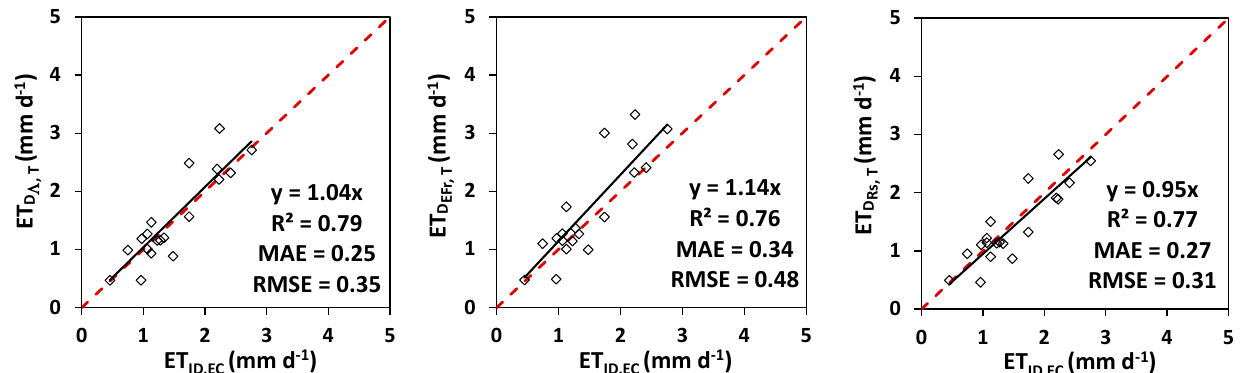
Figure 7. Eddy covariance measured actual daily evapotranspiration (ET ID, EC ) vs. tower-derived upscaled actual daily evapotranspiration based on the Λ scaling factor (ET D Λ , T ), EF r scaling factor (ET DEFr, T ) and Rs 24 /Rs i scaling factor (ET DRs,T ) during the images acquisition days. The red dashed lines represent the 1:1 lines. MAE and RMSE represent the mean absolute error and the root mean square error in mm · d − 1 , respectively.